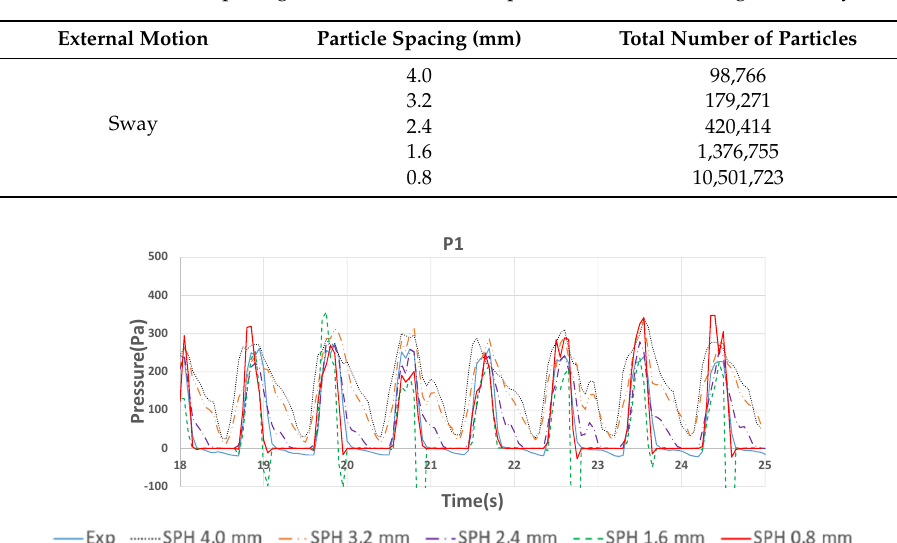
Table 4. Particle spacing and total numbers of particles for the convergence study.